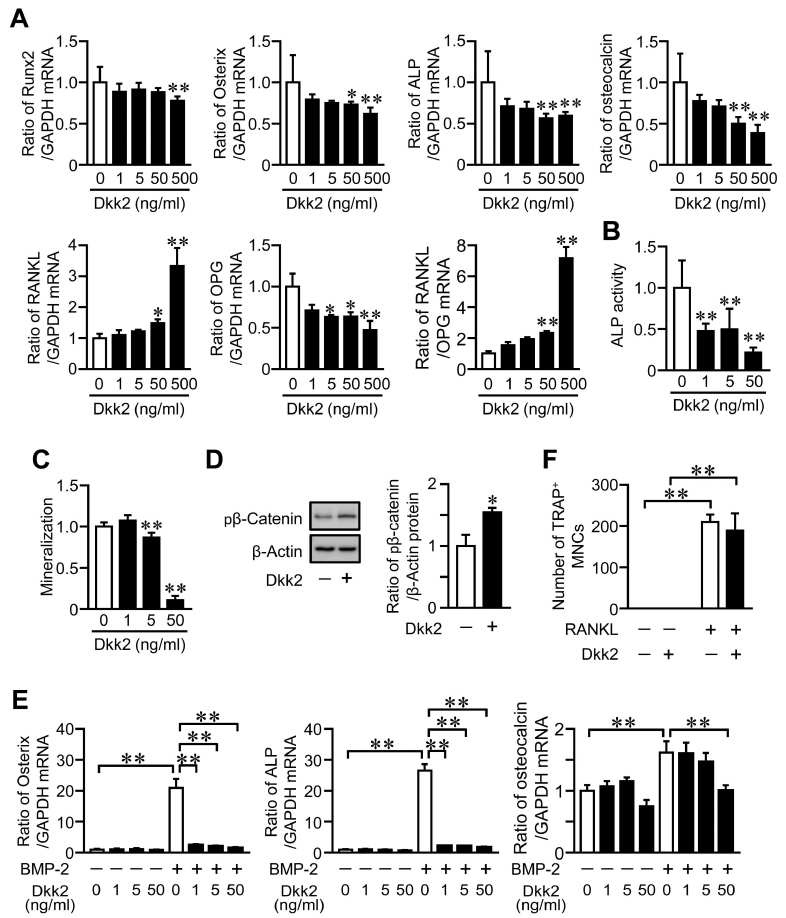
Figure 6. E ff ects of Dkk2 on the osteoblast phenotypes and osteoclast formation. ( A ) Total RNA